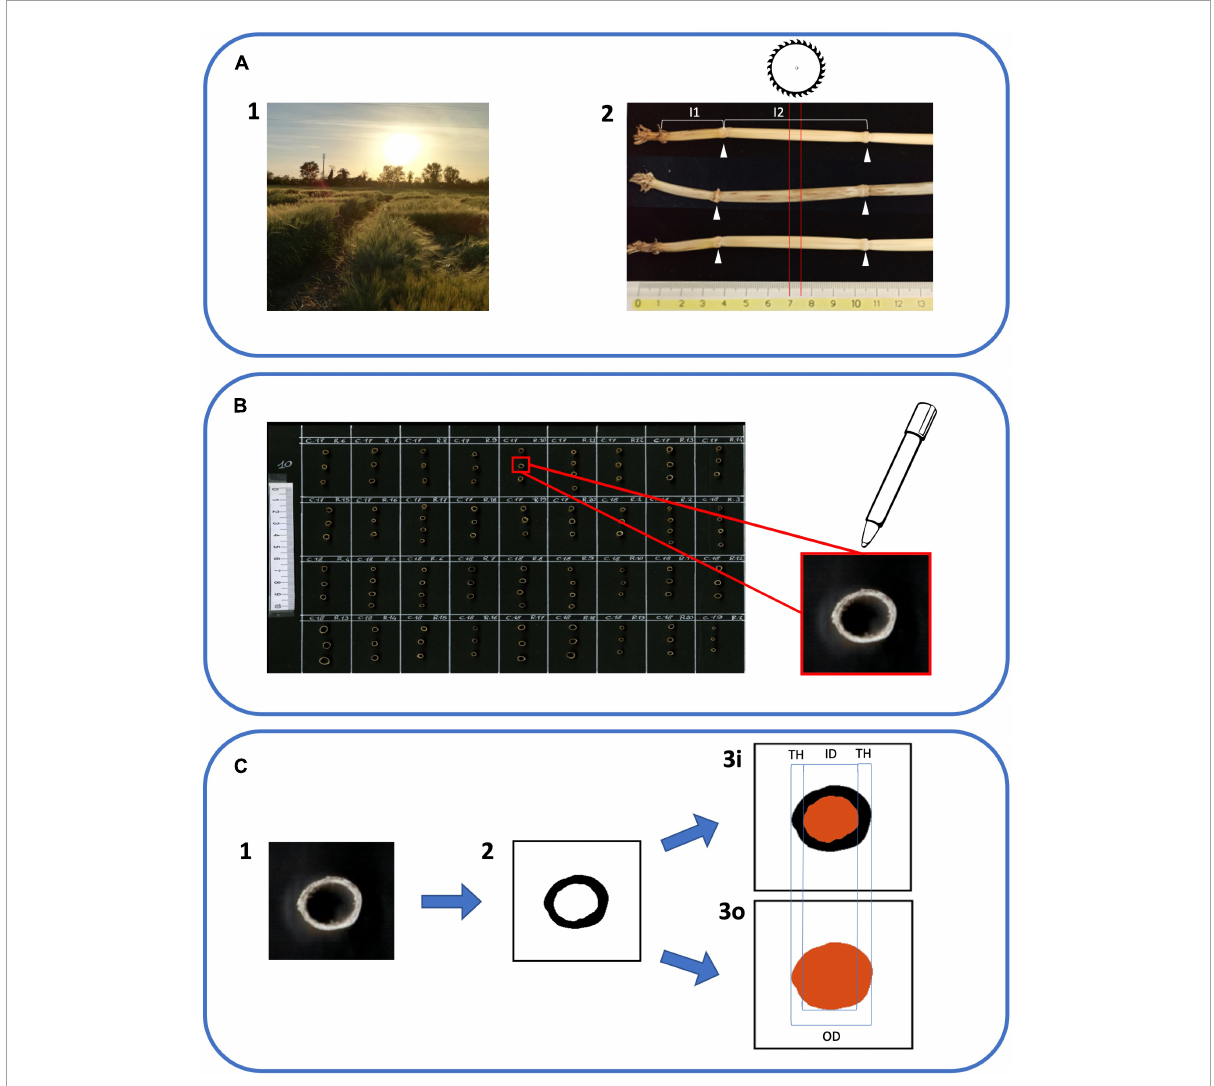
FIGURE1 Workflow of phenotyping protocol for culm morphology traits. (A1) Barley specimens were gathered when plants reached Zadoks stage 90 (grain ripening). Three random plants were collected from each plot. (A2) Samples were cleaned and the main culm was selected for each plant. The first internode (I1) was identified as the most basal internode ≥ 1 cm. The second internode (I2) was the one immediately above (white arrowheads indicate the positions of flanking nodes). Five mm tall sections from the center of I2 (red lines) were obtained using a dedicated circular saw. (B) Sections were attached to black A4 cardboard with superglue and organized on the cardboard following the plot order in the field. The upper part of each section was highlighted with a bright white marker in order to enhance the contrast with the blackboard. (C1) Cardboards with I2 sections were scanned using a flat office scanner to obtain 300 dpi color images. (C2) Using the software ImageJ with a dedicated macro the I2 section images were converted to black and white images. (C3i) ImageJ software was able to isolate and measure